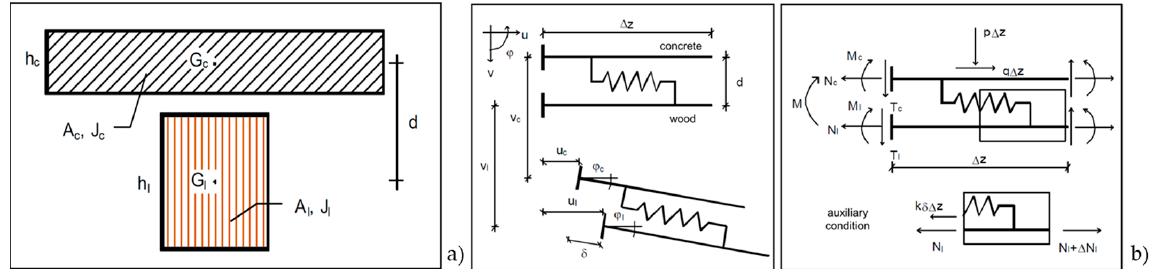
Figure 11. ( a ) Timber–concrete composite section studied in [51]; ( b ) kinematic and static variables that regulate the system by referring to an infinitesimal length D z of the beam.